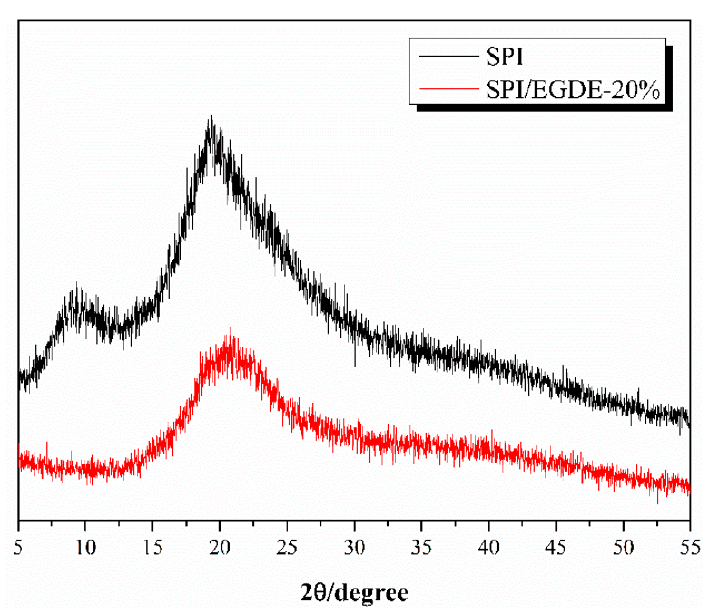
Figure 3. XRD patterns of SPI powder and SPI/EGDE-20% membrane.